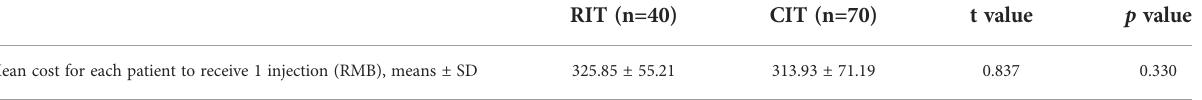
Mean cost for each patient to receive 1 injection (RMB), means ± SD RIT, rush subcutaneous immunotherapy+1 dose of anti-IgE combination; CIT, conventional allergen immunotherapy; SD, standard deviation.